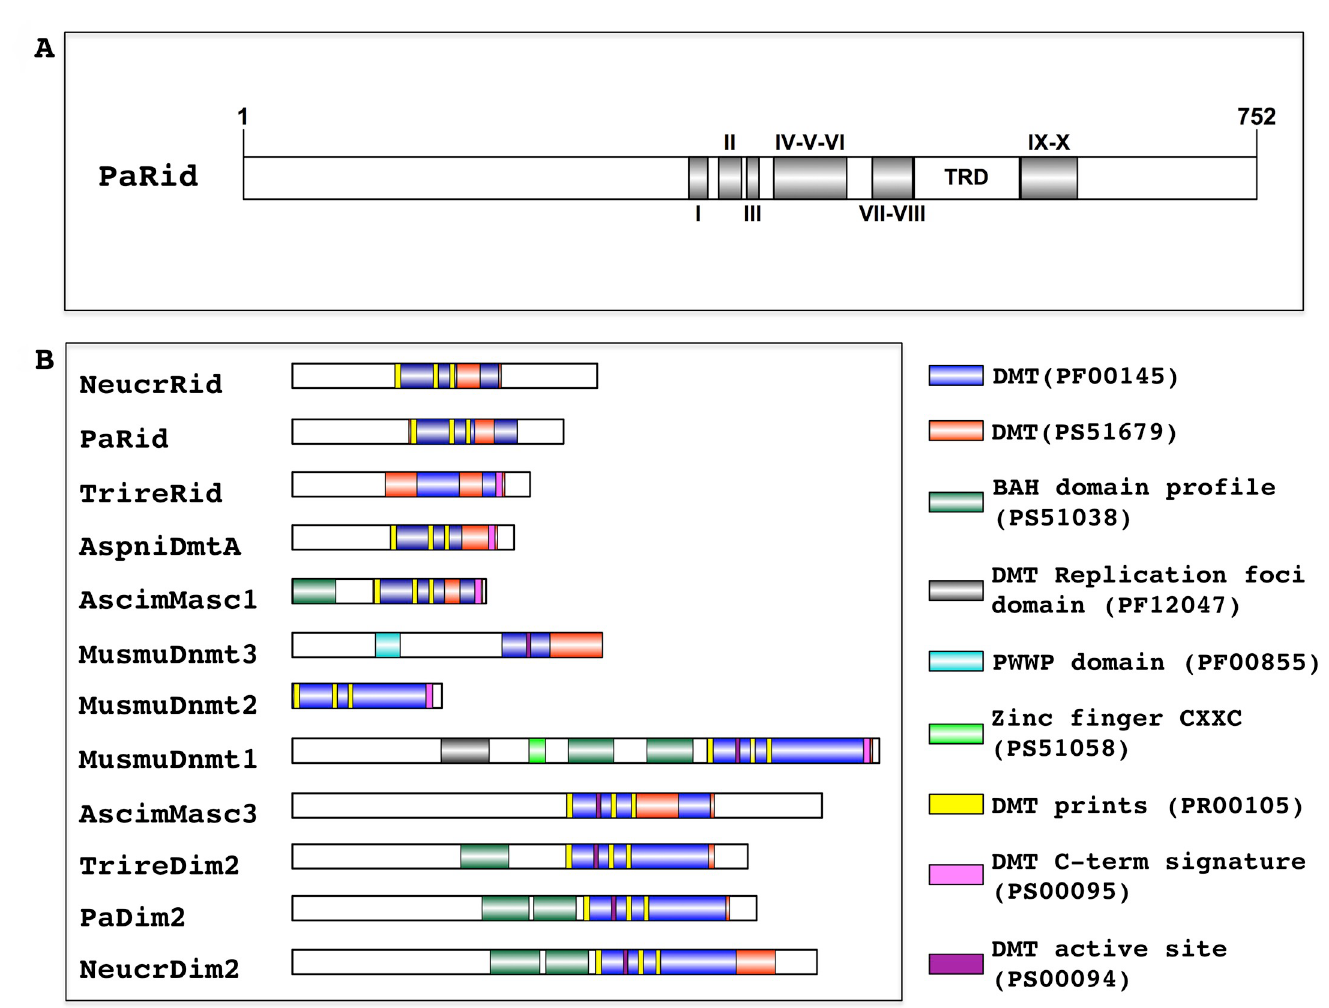
Fig 1. Structural analysis of DNA methyltransferase proteins. ( A ) Domain architecture of P . anserina putative DNA methyltransferase PaRid. The catalytic domains contain 10 conserved motifs (I—X) and a target recognition domain (TRD) located between the motifs VIII and IX. The amino acid length is indicated. ( B ) Domain architecture of DNA methyltransferase proteins (DMT). The functional domain analysis was performed using InterProScan and visualized using IBS. Mus musculus : MusmuDnmt1: NP_001300940.1, MusmuDnmt2: NP_034197.3, MusmuDnmt3A: NP_031898.1; Ascobolus immersus , AscimMasc1 (AAC49849.1), AscimMasc3; Aspergillus nidulans AspniDmtA: XP_664242.1, Neurospora crassa NeucrRid: AAM27408.1, NeucrDim2: XP_959891.1; Podospora anserina PaDim2: Pa_5_9100; PaRid: Pa_1_19440; Trichoderma reesei TrireDim2 XP_006964860.1; TrireRid: AEM66210.1. Cytosine-specific DNA methyltransferase domains: PF00145, PR00105, PS51679, PS00095, PS00094; protein-DNA interaction domains: bromo-associated homology (BAH) domain PS51038, Replication foci